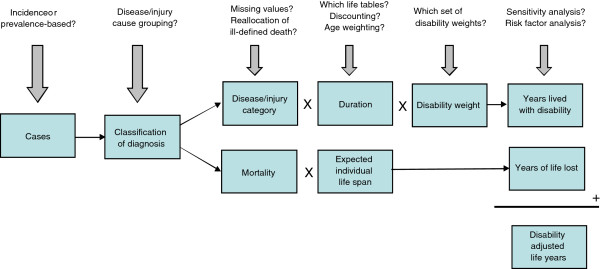
Conceptual model.